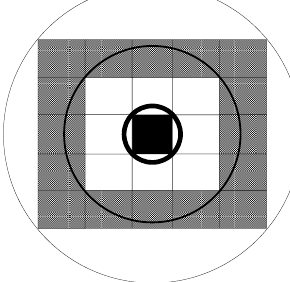
Figure. 1 Same neighborhood sets